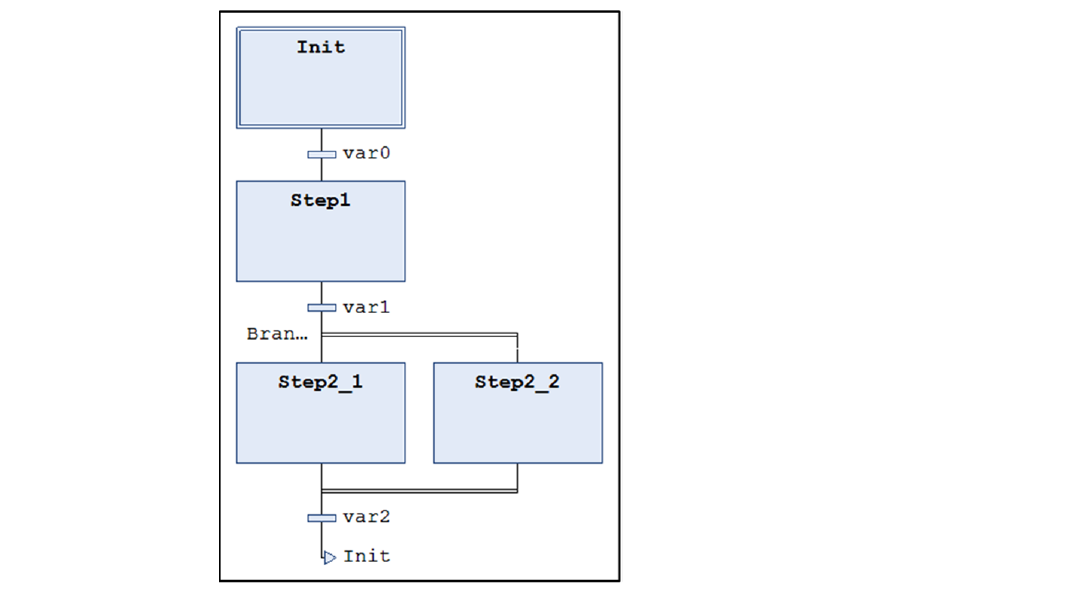
Figure 8. Example of SFC graphical programming language for PLC.